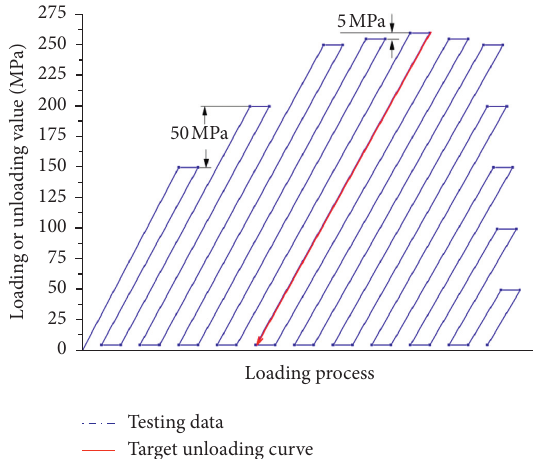
Figure 5: The loading and unloading path diagram.